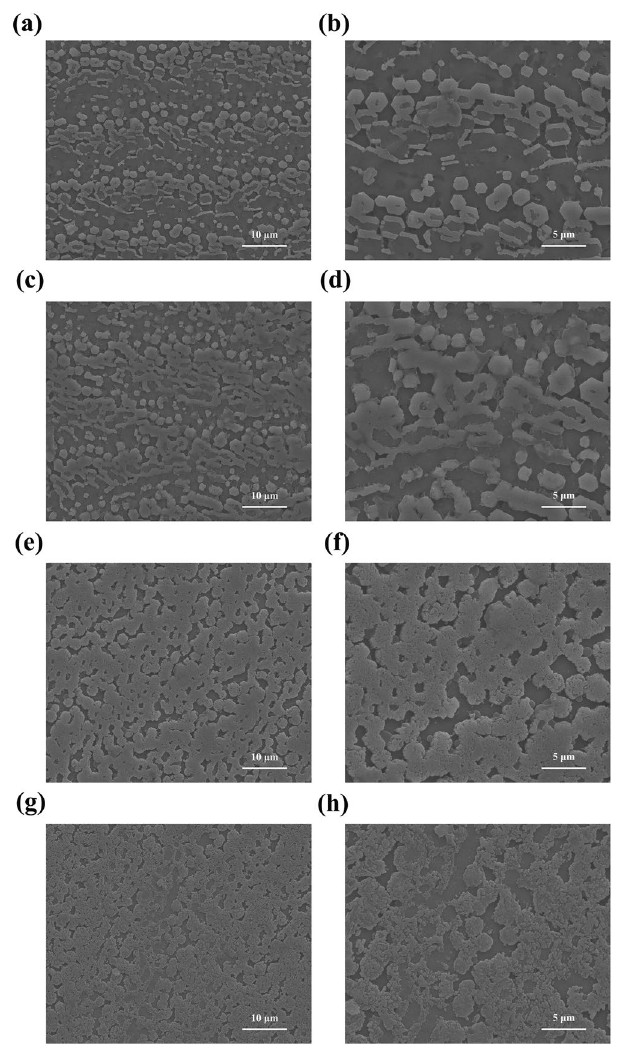
Figure 4. Effects of the inhibition of PfY2 on regulating the nacreous layer of inner shell. ( a , b ) SEM images of the normal shell nacreous layers from oysters injected with water. ( c , d ) SEM images of the nacreous layers in GFP-injected group shells. ( e , f ) SEM images of the nacreous layers in 60 μ g PfY2 dsRNA injected group shells. ( g , h ) SEM images of the nacreous layers in 120 μ g PfY2 dsRNA injected group shells. ( b , d , f , h ) showed an enlargement of ( a , c , e , g ) respectively.